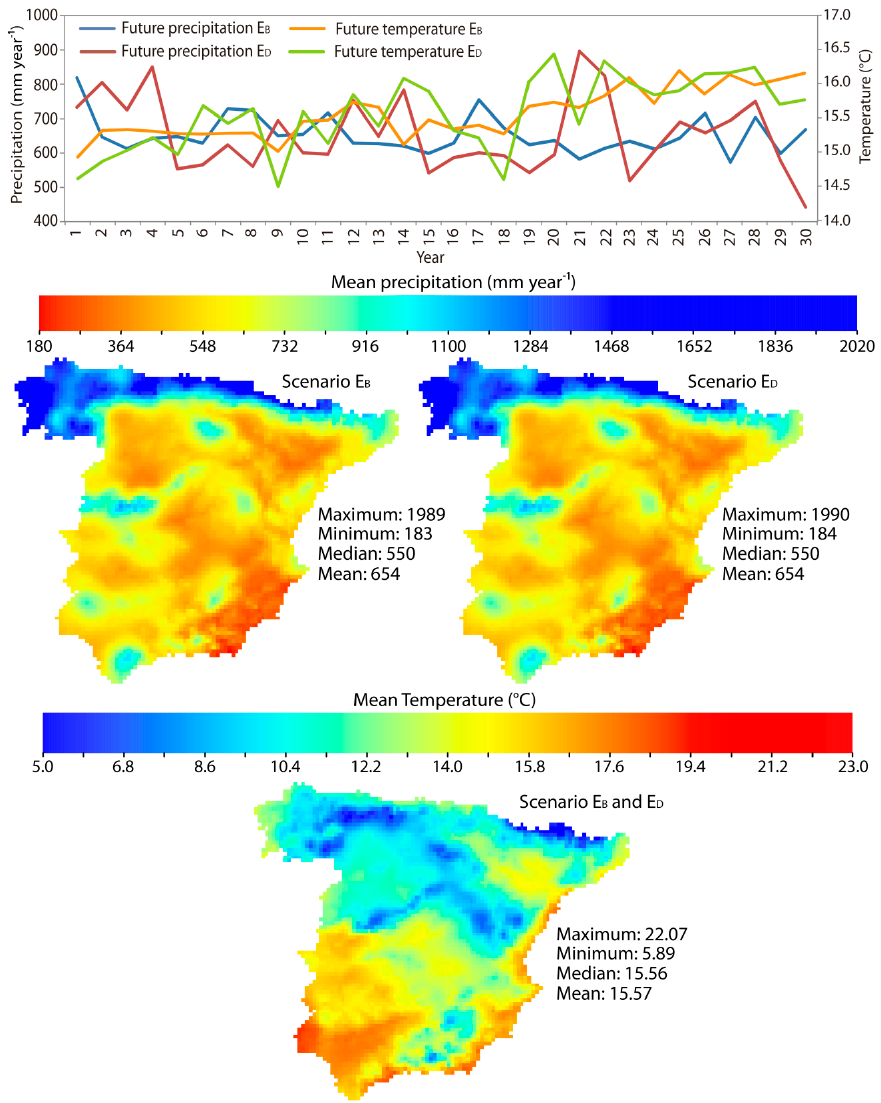
Figure 4. Potential future mean precipitation (mm year − 1 ) and temperature ( ◦ C) obtained with the equi-feasible delta and bias ensembles scenarios (E D , E B ). Modified from [29].